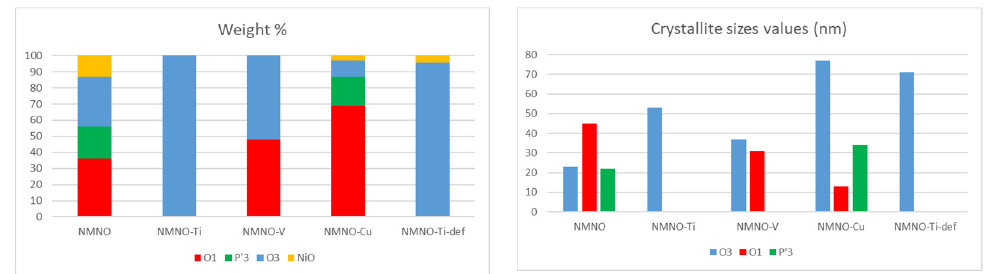
Figure 3. Weight percentages and crystallite sizes values obtained from Rietveld refinements of the different polymorphs for all the samples.